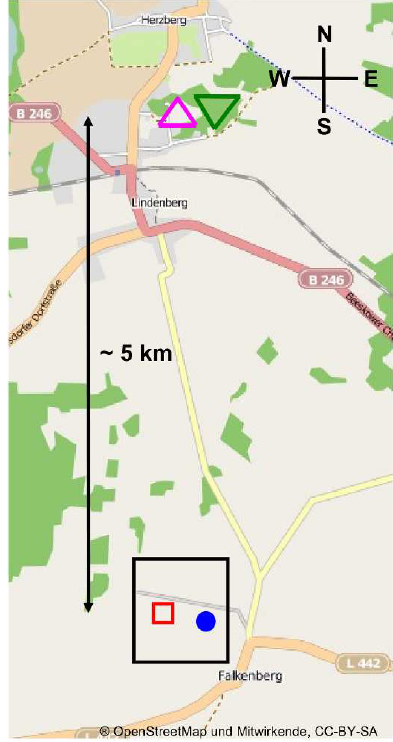
Fig. 3. Approximated location of the instruments at MOL-RAO and the location of flight path of vertical profile of the M 2 AV. The green triangle shows the position of the wind profiler, the pink triangle the position of the MWRP, the small red square the position of the sodar, the blue circle the position of the tower, and the large black square represents one square of the flight path. The radiosonde re- lease point is close to the position of the